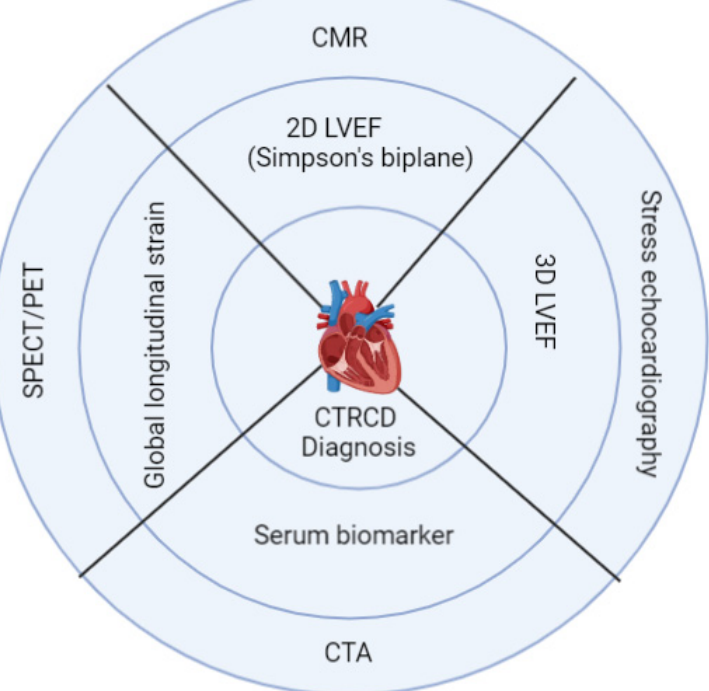
Figure 1. Serum cardiac biomarker and imaging to detect cardiotoxicity. First-line tests are repre- sented in the inner circle, and second-line tests (represented in the outer circle), including advanced imaging techniques, are reserved for a certain group of patients where first-line tests are inadequate or specific information about coronary artery disease is needed. [2D: two-dimensional; LVEF: left ventricular ejection fraction; 3-D: three-dimensional; CTRCD: cancer treatment-related cardiac dys- function; CMR: cardiac magnetic resonance imaging; CTA: computerized tomographic angiography; SPECT: single-photon electron computed tomography; PET: positron emission tomogra-